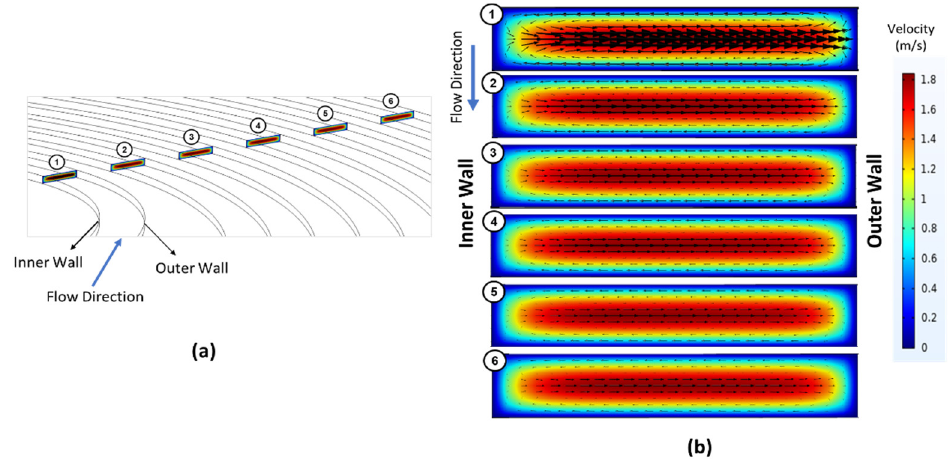
Figure 3. ( a ) Six different cut-plane positions labeled starting from the inner loop along the primary flow direction, and ( b ) a closer look at the vectoral variation of lateral velocity distributions over the colored velocity profile of the primary flow at six different cross-sections throughout the channel.